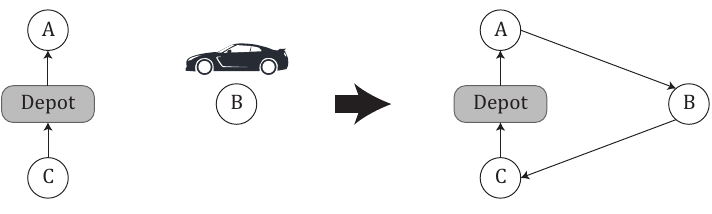
Figure 4. Example of In-move of B.